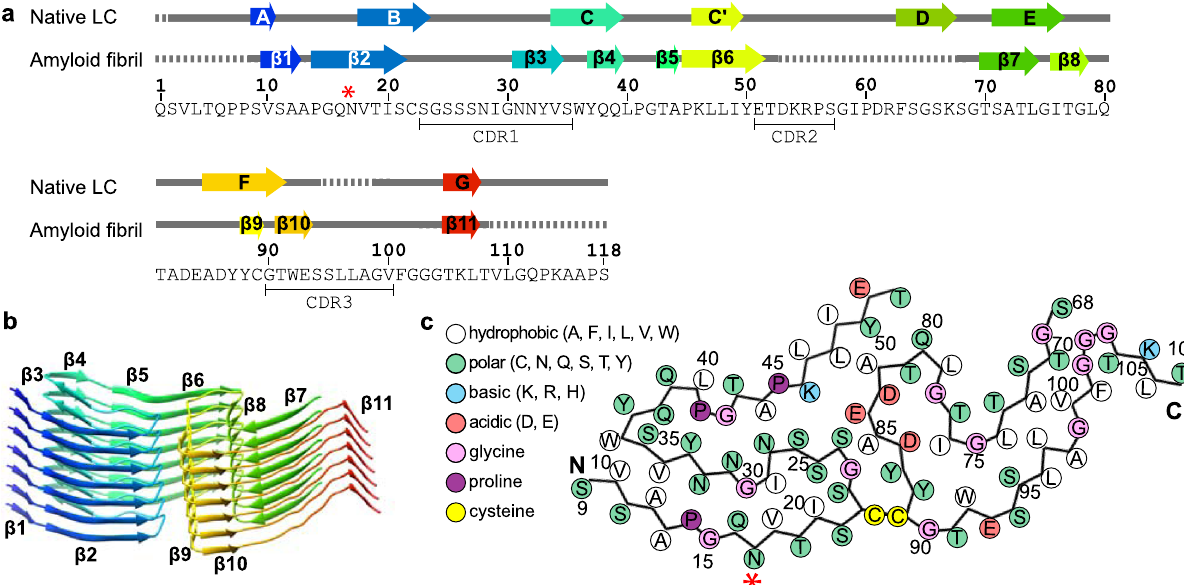
Fig. 3 Location of the secondary structural elements and mutational sites in the fi bril structure. a Amino acid sequence of the FOR001 fi bril protein and secondary structural elements of the FOR001 fi bril protein (PDB 7NSL) and of a crystal structure of a natively folded LC (PDB 4ODH 10.2210/pdb4ODH/ pdb) containing an IGLV1-51*02 segment. Arrows indicate β -strands in the structure, rainbow-colored from N (blue) to C terminus (red). Dotted lines represent disordered segments. Red star: location of the glycosylation. b Stack of seven protein layers of the fi bril, showing the β -strands β 1 – β 11 with the same coloring as in ( a ). c Schematic representation of the fi bril protein fold. Red star: location of the